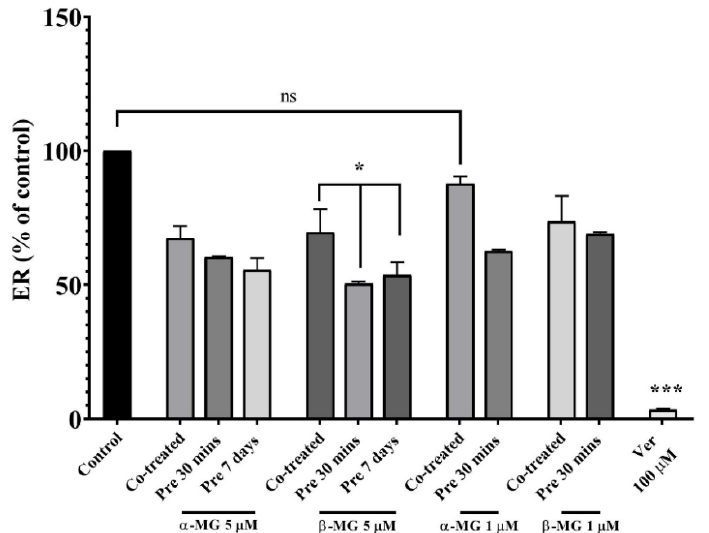
Figure 4. Efflux ratio (ER) showed as a percent of control, Rho123 added simultaneously with test compounds at the beginning (co-treated), at 30 min after incubation with test compounds (pre 30 min), or 7 days after incubation with test compounds (pre 7 days). ( n = 7) (* p < 0.05 compared to the control) (*** p < 0.001, compared to the control) (ns; not significant compared to the control).